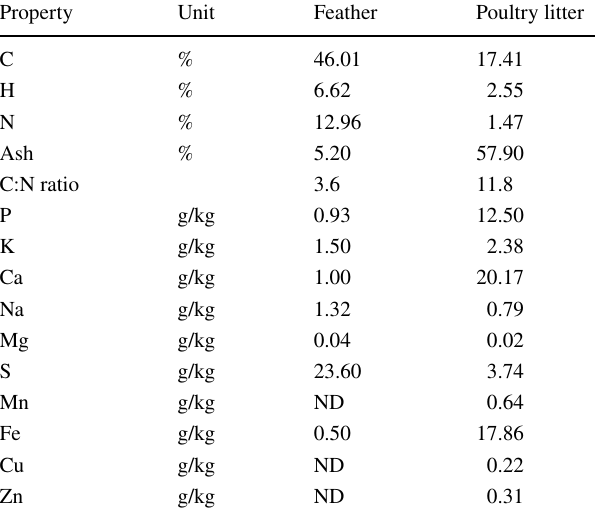
Table 1 Properties of feedstocks: feather and poultry litter Property